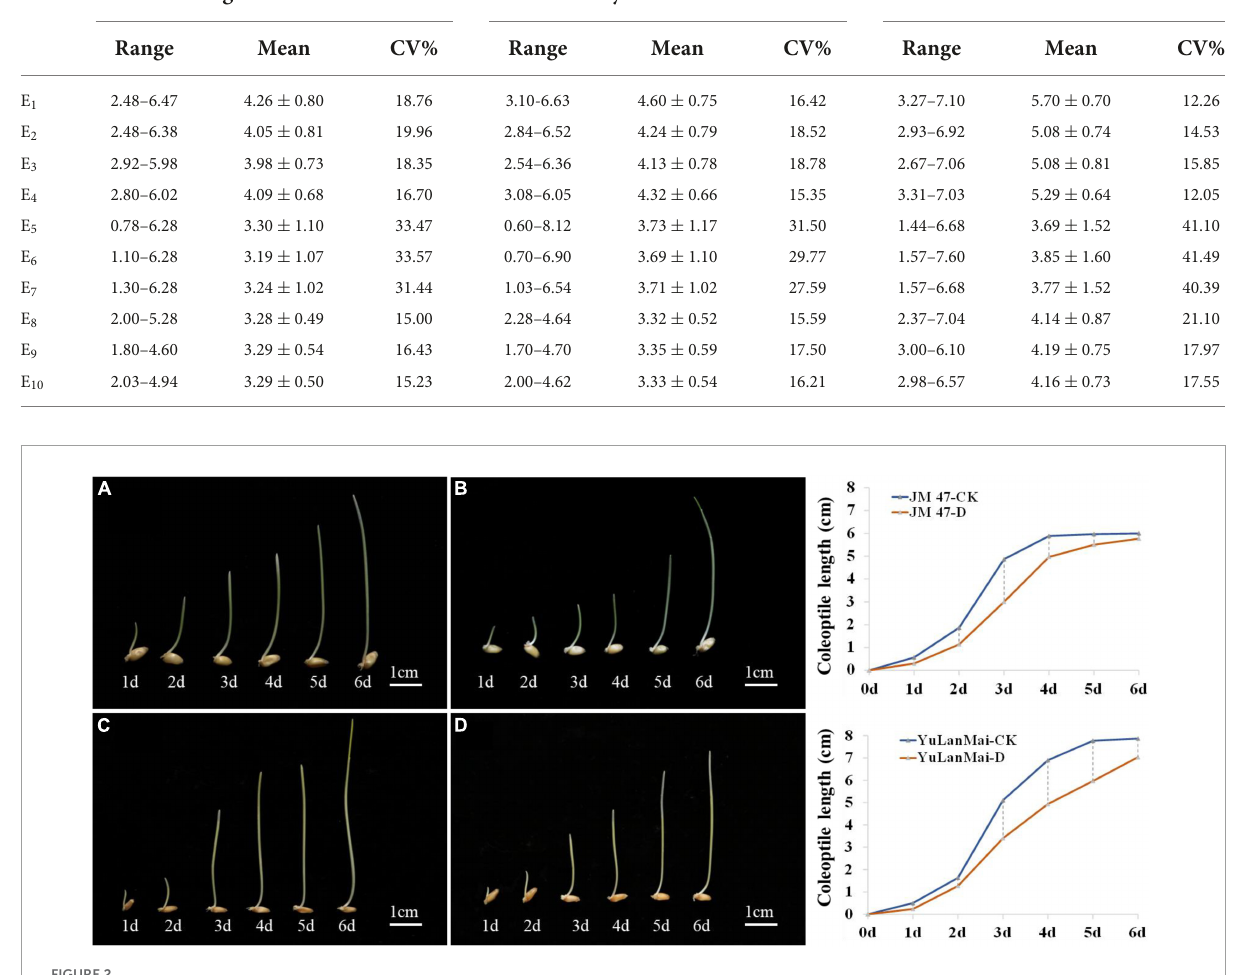
FIGURE2 Dynamic changes of coleoptile length in a growth cycle. (A) Growth dynamics of Jinmai 47 under C 1 ; (B) Growth dynamics of Jinmai 47 under C 2 ; (C) Growth dynamics of Yulanmai wheat under C 1 ; (D) Growth dynamics of Yulanmai under C 2 ; The graph on the right is the growth curve of Jinmai 47 and Yulanmai respectively (X is the growth days, Y is the coleoptile